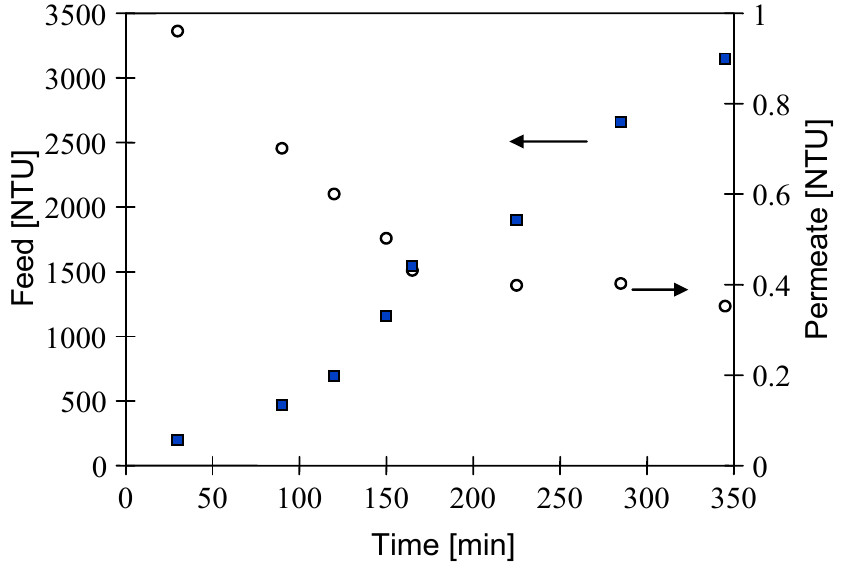
Figure 18. Changes in feed and permeate turbidity during MF of real oily wastewater #2 (Figure 17, series S1). Module MF2, TMP = 0.05 MPa, V F = 0.5 m/s, T = 22 °C.